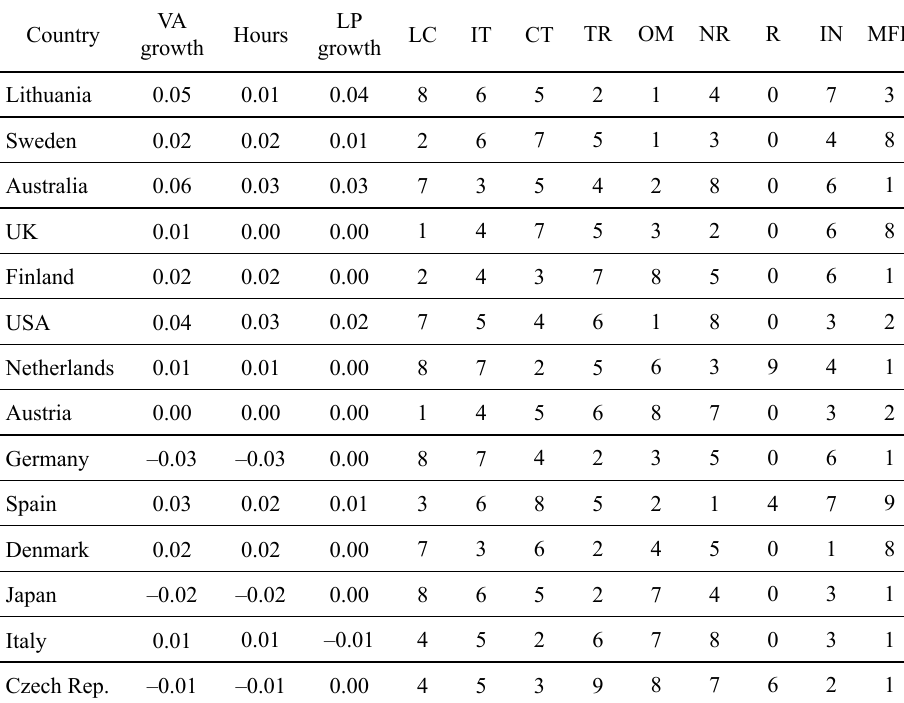
Table 2. Ranked labour productivity (LP) contributors for the construction industry during the research period of